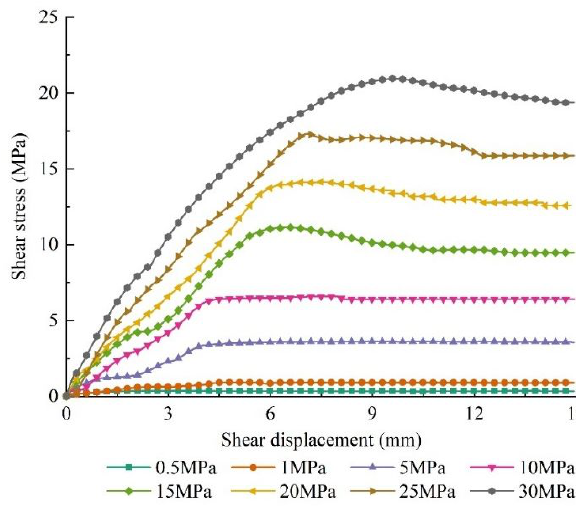
Figure 9: Shear stress-displacement curve of double saw-tooth rock joints under different normal stresses